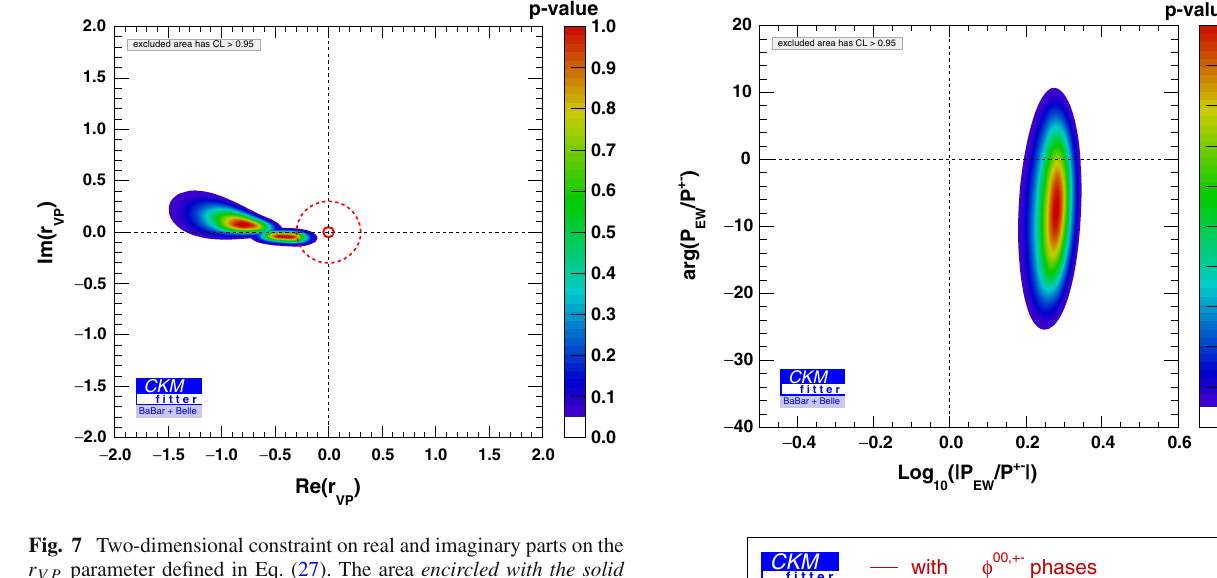
(cid:17) (cid:17) (cid:17) (cid:17) P / P +− EW